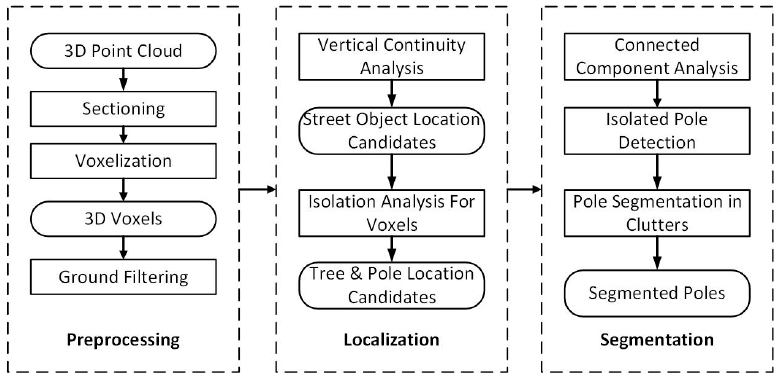
Figure 1. Workflow of the proposed